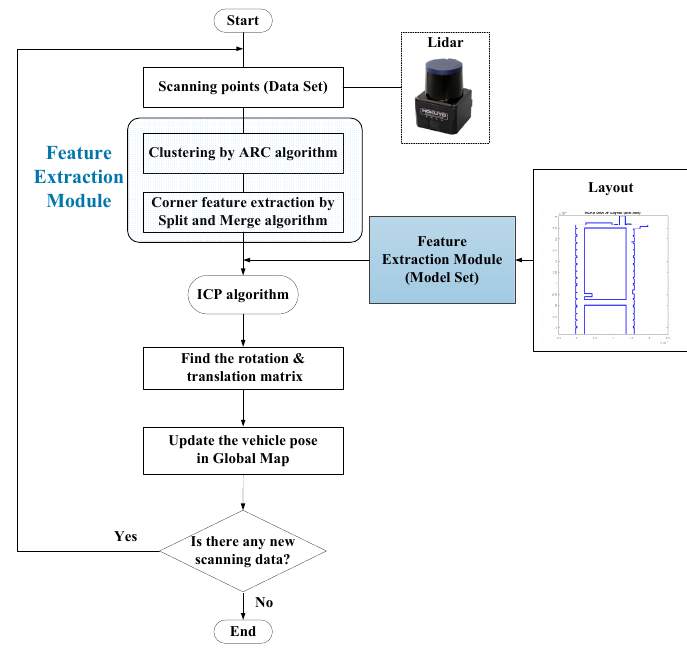
Figure 4. Corner-feature-based pose estimation.